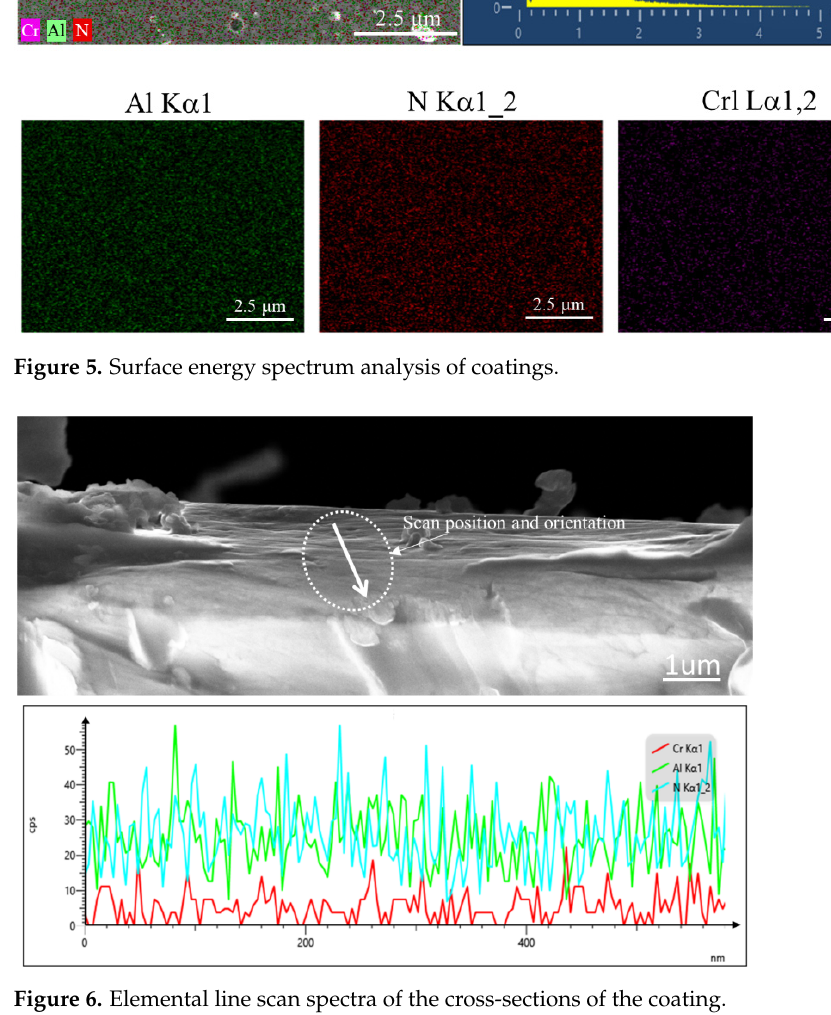
Figure 6. Elemental line scan spectra of the cross ‐ sections of the coating.